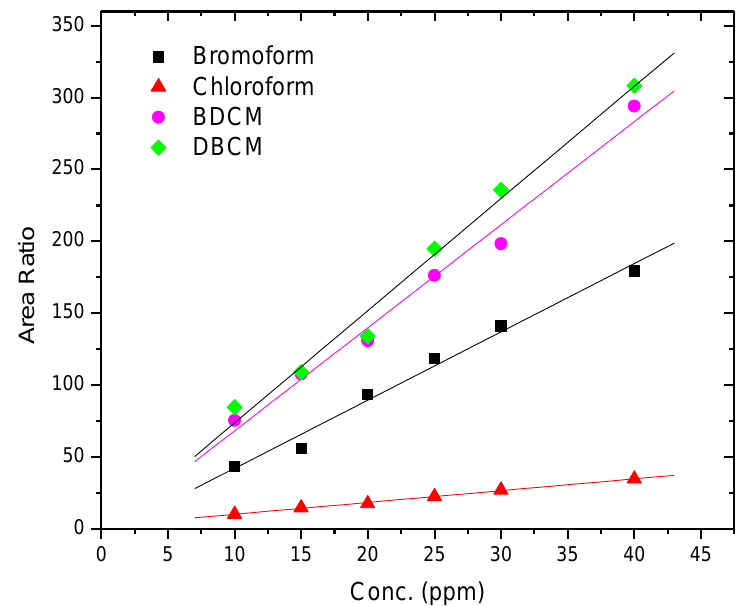
Figure 2. Gas chromatography (GC)-based calibration curve of the component THMs in water at pH 6.5 and 295 K. The value for R 2 is given in parentheses for each THM: CHCl 3 (0.998), BDCM (0.993), DBCM (0.993), and CHBr 3 (0.993).